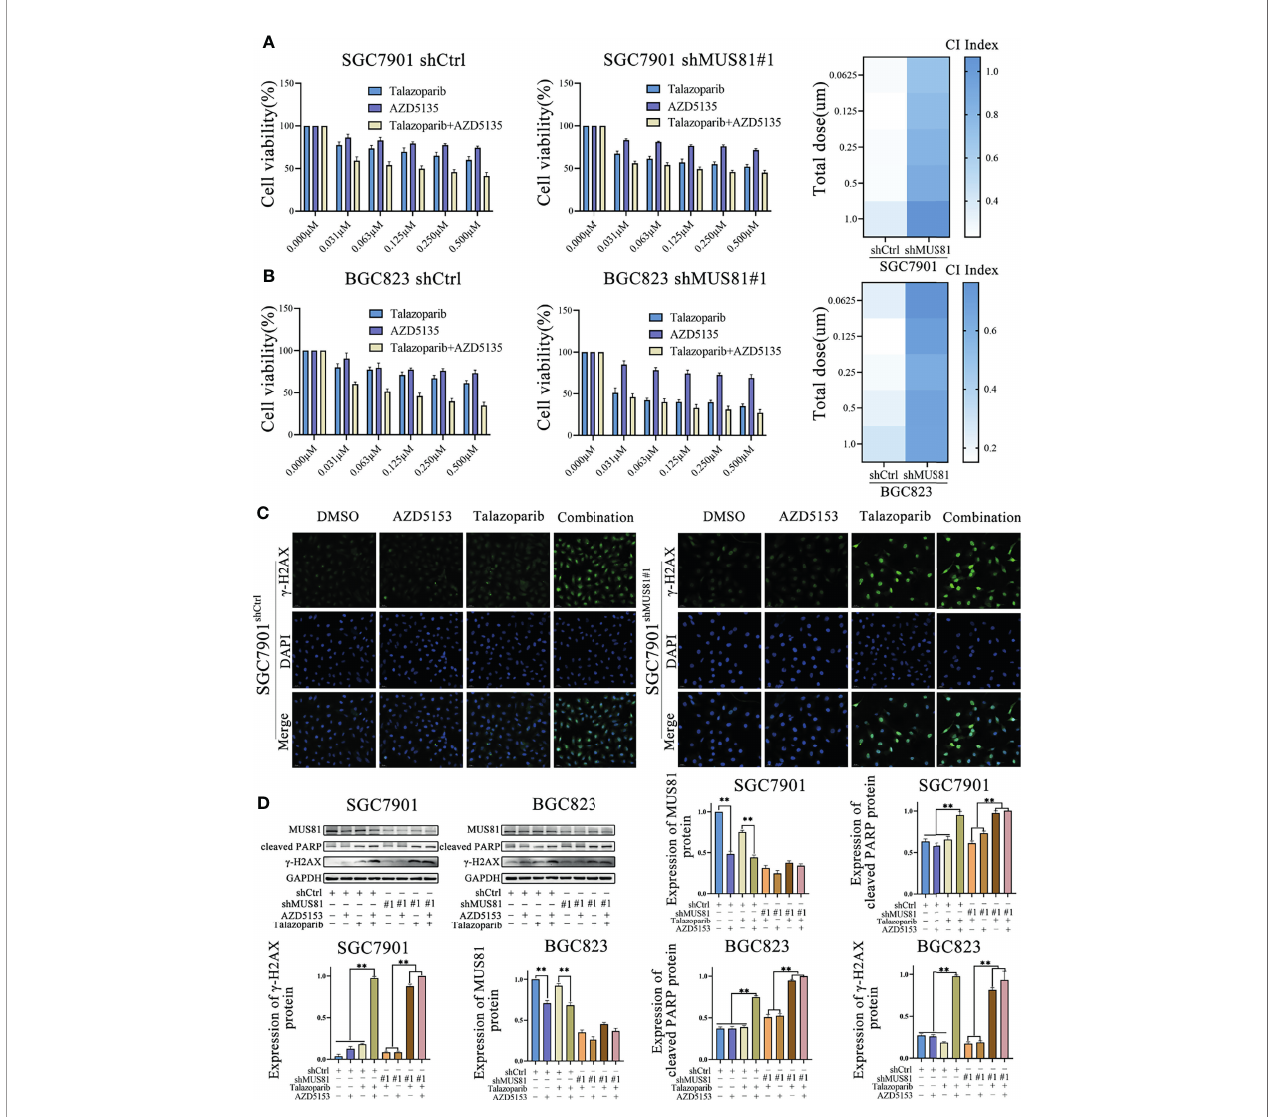
FIGURE 6 | AZD5153 sensitizes the talazoparib anticancer effect in a MUS81-dependent manner in gastric cancer cells. (A, B) Viability of cells treated with monotherapy and combination therapy for 5 d, as determined using MTS ( t -test). At fi ve gradually increasing concentrations (0.0625 µmol/L to 1.000 µmol/L), the mean CI of SGC7901 shCtrl cells were 0.26, 0.23, 0.25, 0.26, and 0.36, respectively; the mean CI of SGC7901 shMU81 cells were 0.69, 0.75, 0.81, 0.87, and 1.07, respectively; the mean CI of BGC823 shCtrl cells were 0.23, 0.15, 0.18, 0.21, and 0.29, respectively; the mean CI of BGC823 shMU81 cells were 0.76, 0.69, 0.62, 0.67, and 0.67, respectively. The difference between shMU81 and shCtrl groups was statistically signi fi cant (all P < 0.01). (C) Immuno fl uorescence to detect the expression of phosphorylated checkpoint kinase 1 (p-CHK1) in cells treated with DMSO, AZD5153 (1 µmol/L), talazoparib (0.5 µmol/L), or combination therapy for 2 d. Magni fi cation, 400×. (D) Western blot analysis examining the expression of MUS81, cleaved PARP, and g -H2AX in gastric cancer cells after treatment with DMSO, AZD5153 (1 µmol/L), talazoparib (0.5 µmol/L), or combination therapy for 2 d ( t -test). ** P <